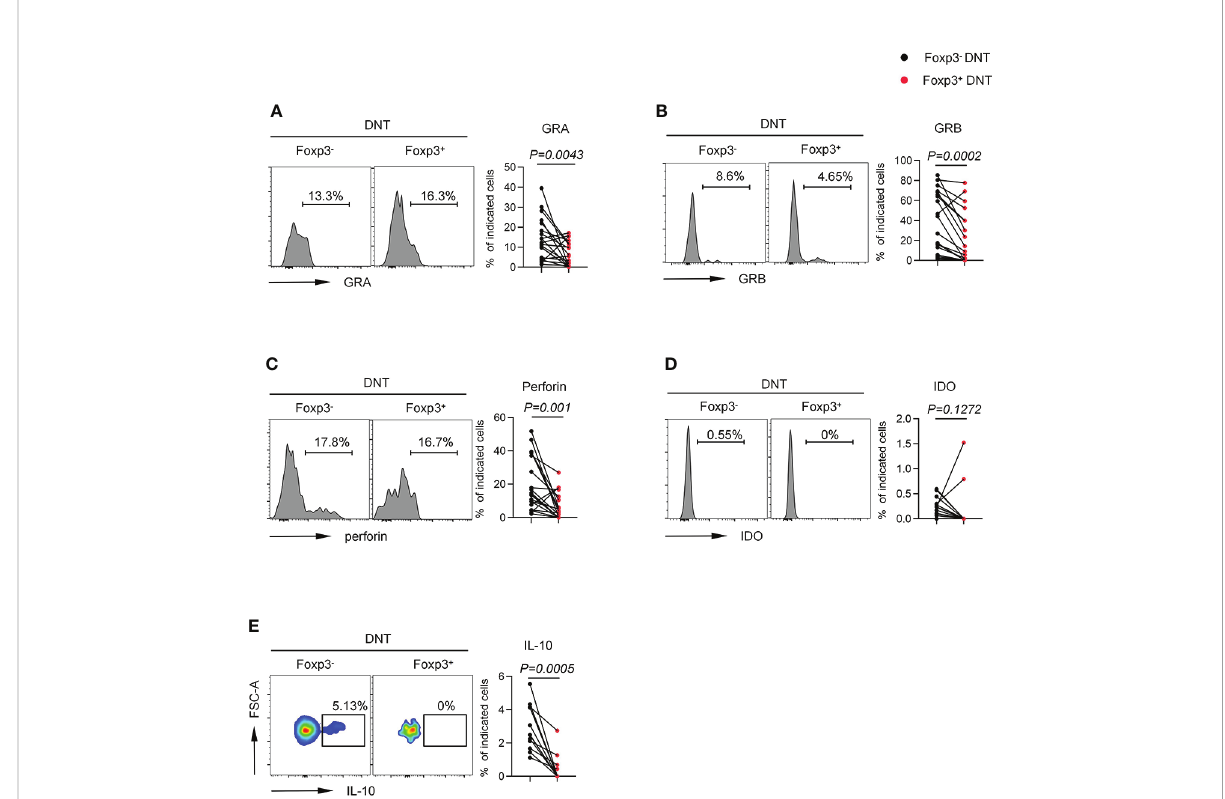
FIGURE 4 Foxp3 + DNT cells secreted different level of cytokine and intracellular proteins compared with their circulating Foxp3 - counterpart in TNs. Flow cytometry analysis of expression of GRA (A) , GRB (B) , Perforin (C) , IDO (D) and IL-10 (E) on Foxp3 - vs . Foxp3 + DNT cells from TNs with baseline CD4 + T cell count ≤ 200 cells/µl. Representative histograms (left) and plots (right) displayed the expression of the above markers on Foxp3 - vs . Foxp3 + DNT cells. Statistical tests were performed using the Wilcoxon matched-pairs signed rank